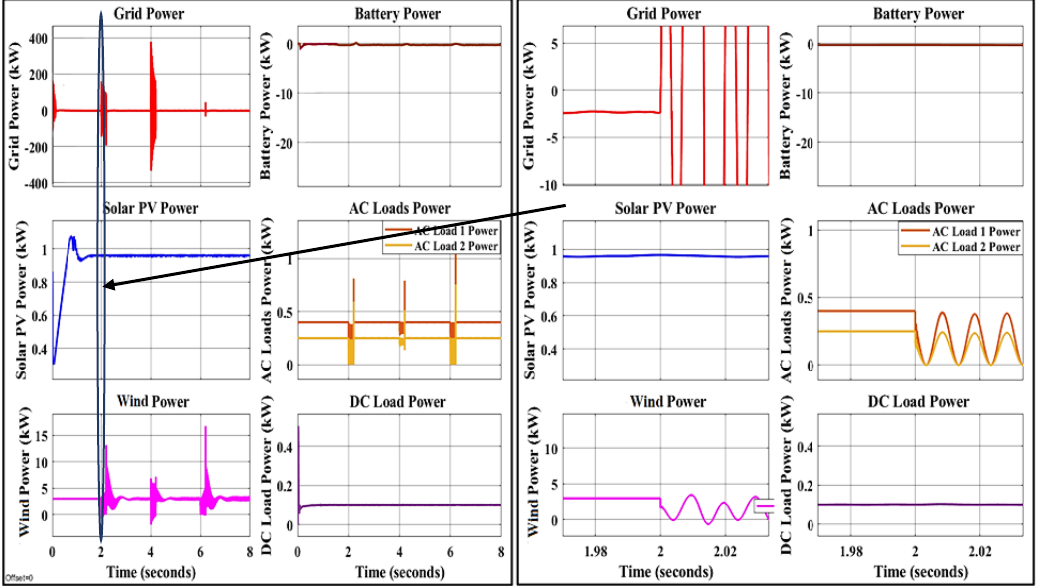
Figure 16. The power of each RER, grid, and AC and DC loads under fault scenario.